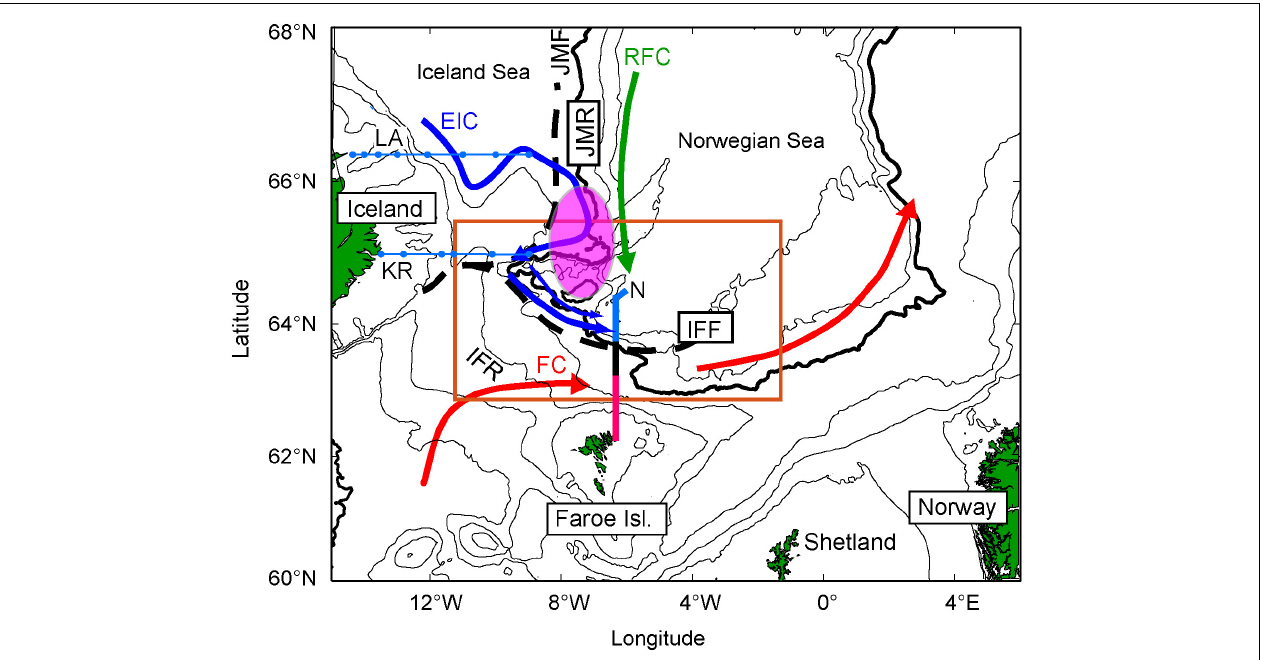
FIGURE 1 | Map of the study region. The orange box defines the main study area. The black stippled lines show the approximate position of the Iceland-Faroe Front (IFF) and Jan Mayen Front (JMF), separating the south-eastward flowing East Icelandic Current (EIC) (blue) and poleward flowing Atlantic Waters (red). The purple circle illustrates the area where the densest aggregation of older herring is observed since around 2003, in May (Eliasen et al., 2021). The Icelandic monitoring sections (KR and LA) are shown in blue, while the Faroese section (N) is divided into an Atlantic (red), frontal (black), and subarctic (blue) regions. FC, Faroe Current; RFC, Recirculated Faroe Current (green); IFR, Iceland Faroe Ridge; JMR, Jan Mayen Ridge; KR, Krossanes; and LA, Langanes East. The 200, 500, 1,000, 2,000 (bold), 2,500, and 3,000 m isobaths are shown in